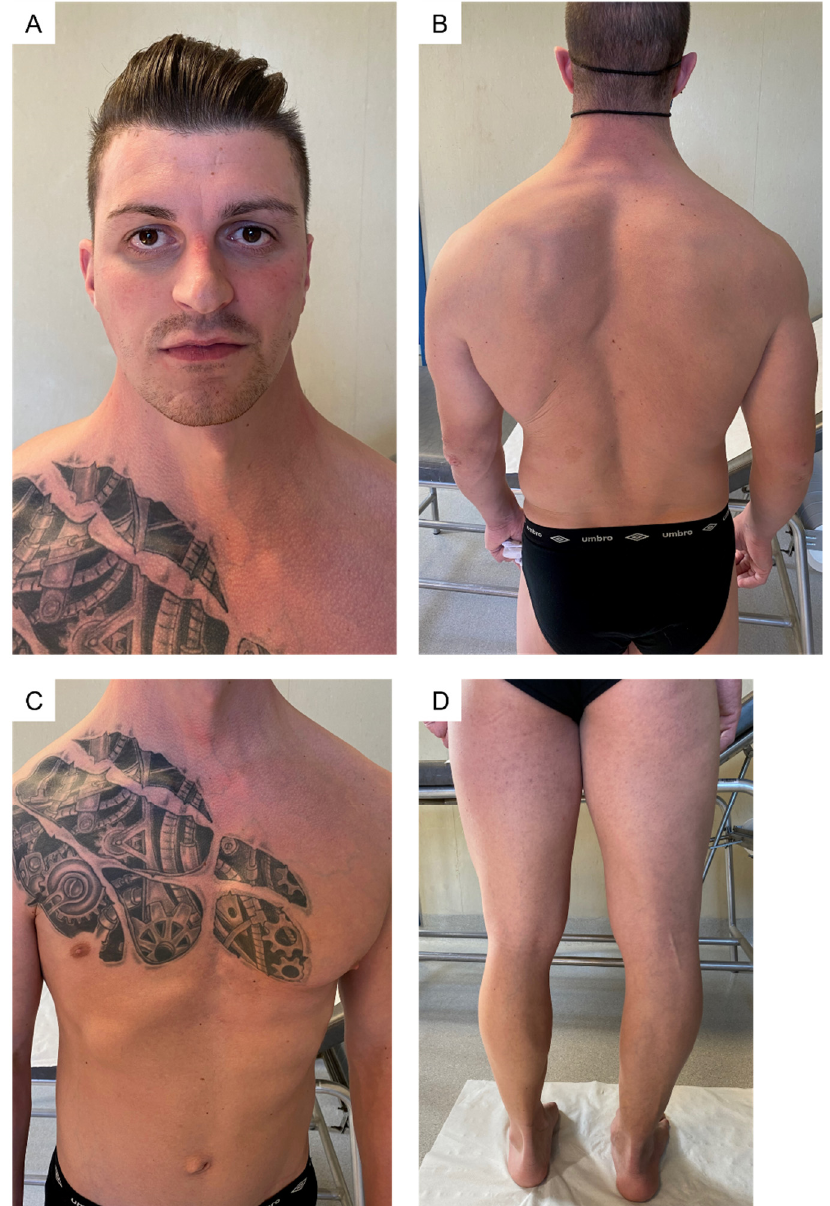
Figure 1. General examination of the patient. ( A ) mild facial dysmorphism (down-slanting palpebral fissures, epicanthus, deep set eyes, malar hypoplasia; ( B ) webbed neck, scoliosis; ( C ) thoracic asymmetry due to unilateral hypoplasia of right pectoralis major muscle; ( D ) lower limbs dysmetria. Skin was dry, markedly hyperextensible (>3 cm dorsum of the hand, >5 cm elbow and neck regions), and translucent, with visible vascular architecture, especially around the neck and chest. Some scars were atrophic, with one on the left elbow presenting with subcutaneous spheroids, while others being hemosiderotic or having a cigarette- paper-like appearance. Piezogenic papules were present at the heels (Figure 3). An oral examination identified hypertrophic double frenulum of the upper lip and hypoplasia of the lingual